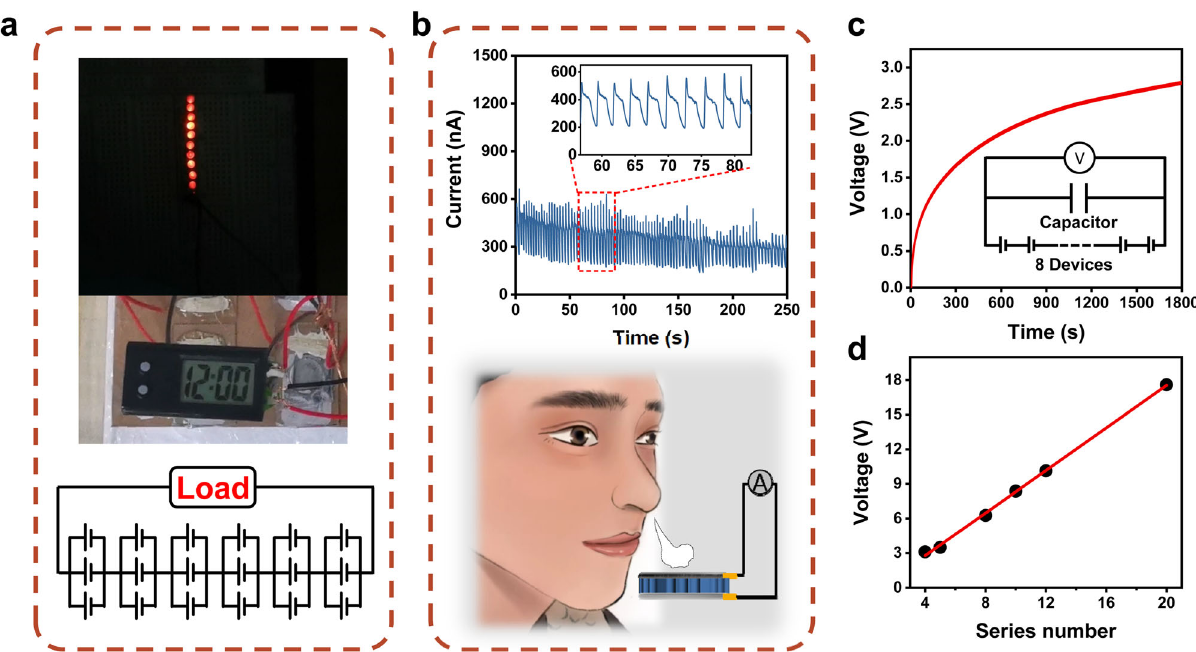
Fig. 5 Application of HEEG devices. a Combination of 18 devices in series and parallel connection can light up ten LEDs and power up a digital electronic watch directly under laboratory environment ∼ 65% RH, 25 °C. b Self-powered breathing monitoring application and its signal display, the bottom is the test schematic diagram. c 8 units in series charge a 47 μ F capacitor to ~2.8 V in 30 min. d The open-circuit voltage of different number of devices that are connected in